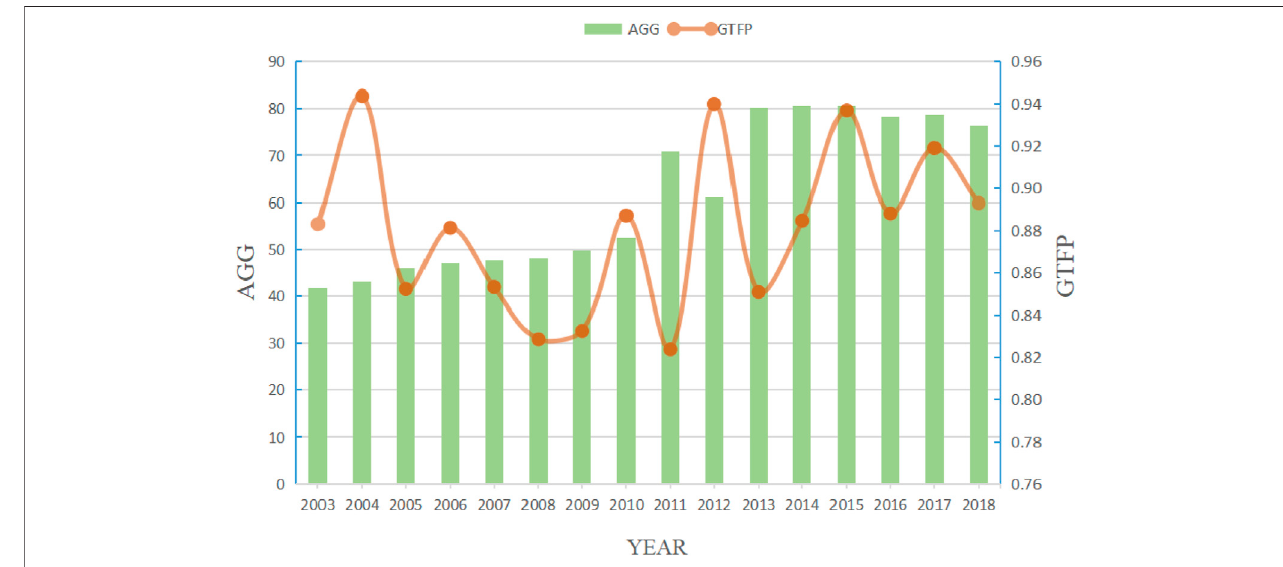
FIGURE 1 | Temporal variation of the GTFP and AGG